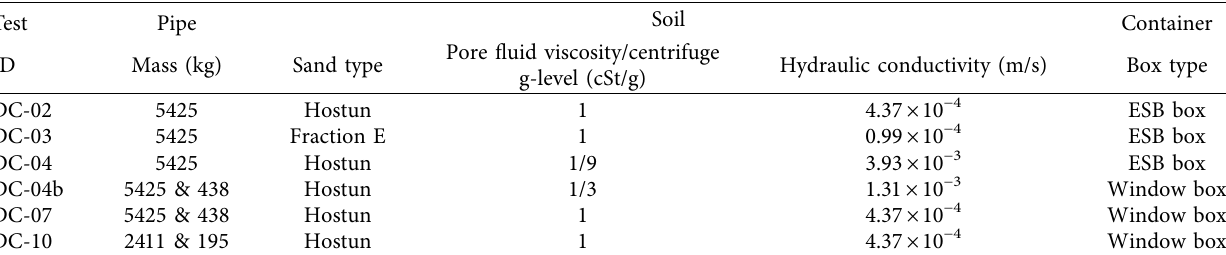
Table 2: Tests characteristics (extracted from [31]).